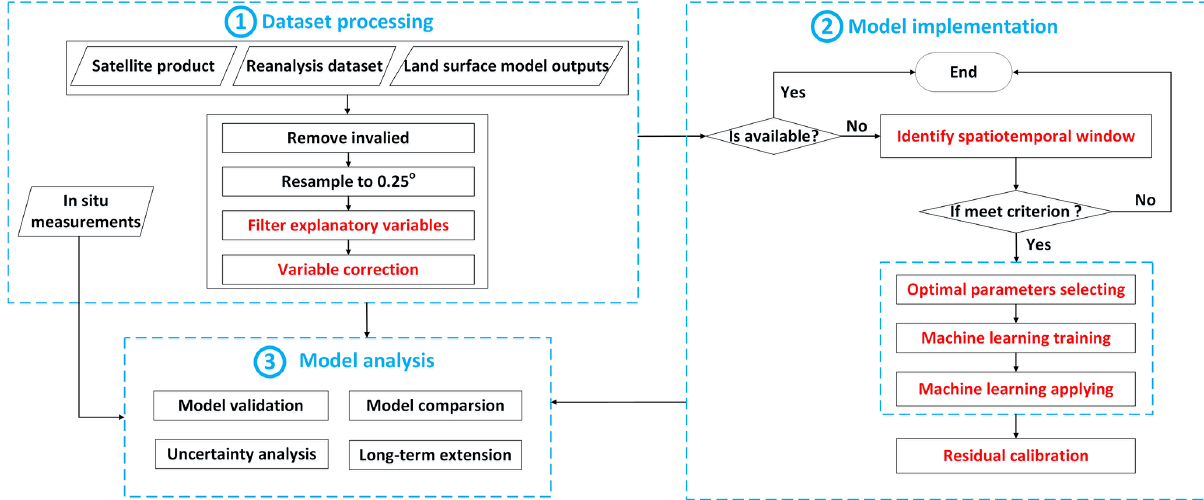
Figure 2. Schematic of the overall